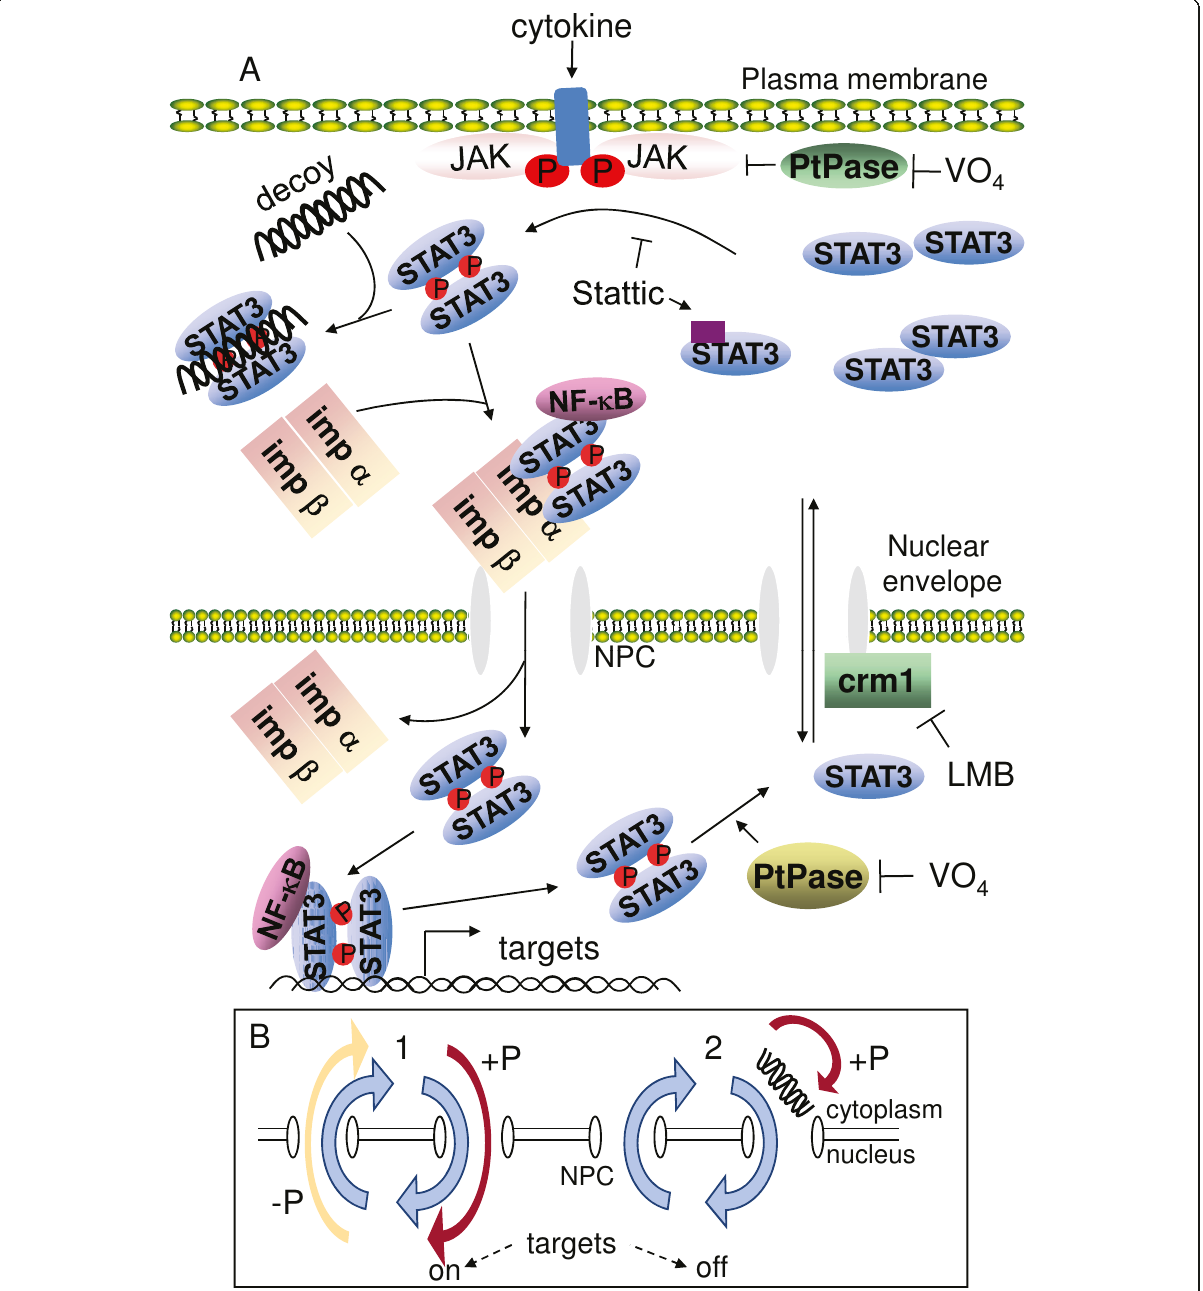
Figure 10 Nucleo-cytoplasmic shuttling of STAT3, and putative mechanism of action of STAT3-decoy ODN . A : Nucleo-cytoplasmic shuttling of activated STAT3. Phosphorylation of STAT3 on tyrosine 705 by the JAK family kinases results in dimerization and interaction with importins (imp), followed by transfer to the nucleus through the nuclear pore complex (NPC). Phospho-STAT3 binds its DNA targets, this is followed by dephosphorylation by a nuclear tyrosine phosphatase. Unphosphorylated STAT3 re-enters the cytoplasm: this depends in part on CRM1, which is inhibited by leptomycin B (LMB). Tyrosine phosphatases which dephosphorylate activated JAKs and phospho-STAT3 are inhibited by sodium vanadate (VO 4 ). Stattic interaction with STAT3 monomers prevents dimerization and nuclear entry. STAT3-decoy ODN (decoy) interaction with active phosphorylated STAT3 dimers is suggested to compete with importin, thereby trapping active STAT3 in the cytoplasm. B : Nucleo-cytoplasmic cycling of activated and non-activated STAT3. Non-activated STAT3 cycles in and out of the nucleus in the absence of activation (phosphorylation: +P) (1, blue arrows). Activated STAT3 enters the nucleus by a transporter-mediated process (1, red arrow) and returns to the cytoplasm following dephosphorylation: -P) (1, yellow arrow). In STAT3-decoy ODN-transfected cells, cycling of non-activated STAT3 is unchanged (2, blue arrows), whereas activated (phosphorylated) STAT3 does not enter the nucleus (2, red arrow). NPC: nuclear pore complex. The scheme in B is adapted from a figure of